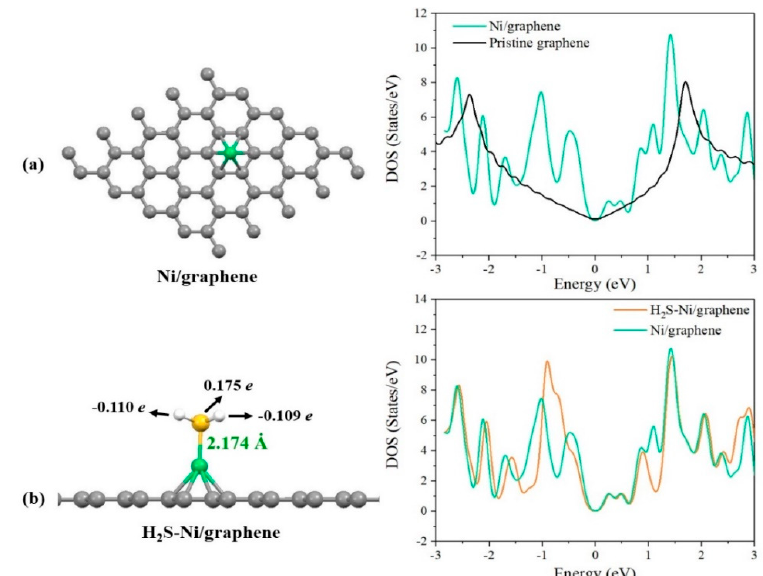
Figure 7. ( a ) Optimized structures of Ni-decorated graphene on the hexagonal site and corresponding DOS plot; ( b ) side view of the optimized structure and geometrical parameters and DOS plot calculated after adsorption of the H 2 S molecule on the surface of Ni-decorated graphene (the Fermi level is set to zero).